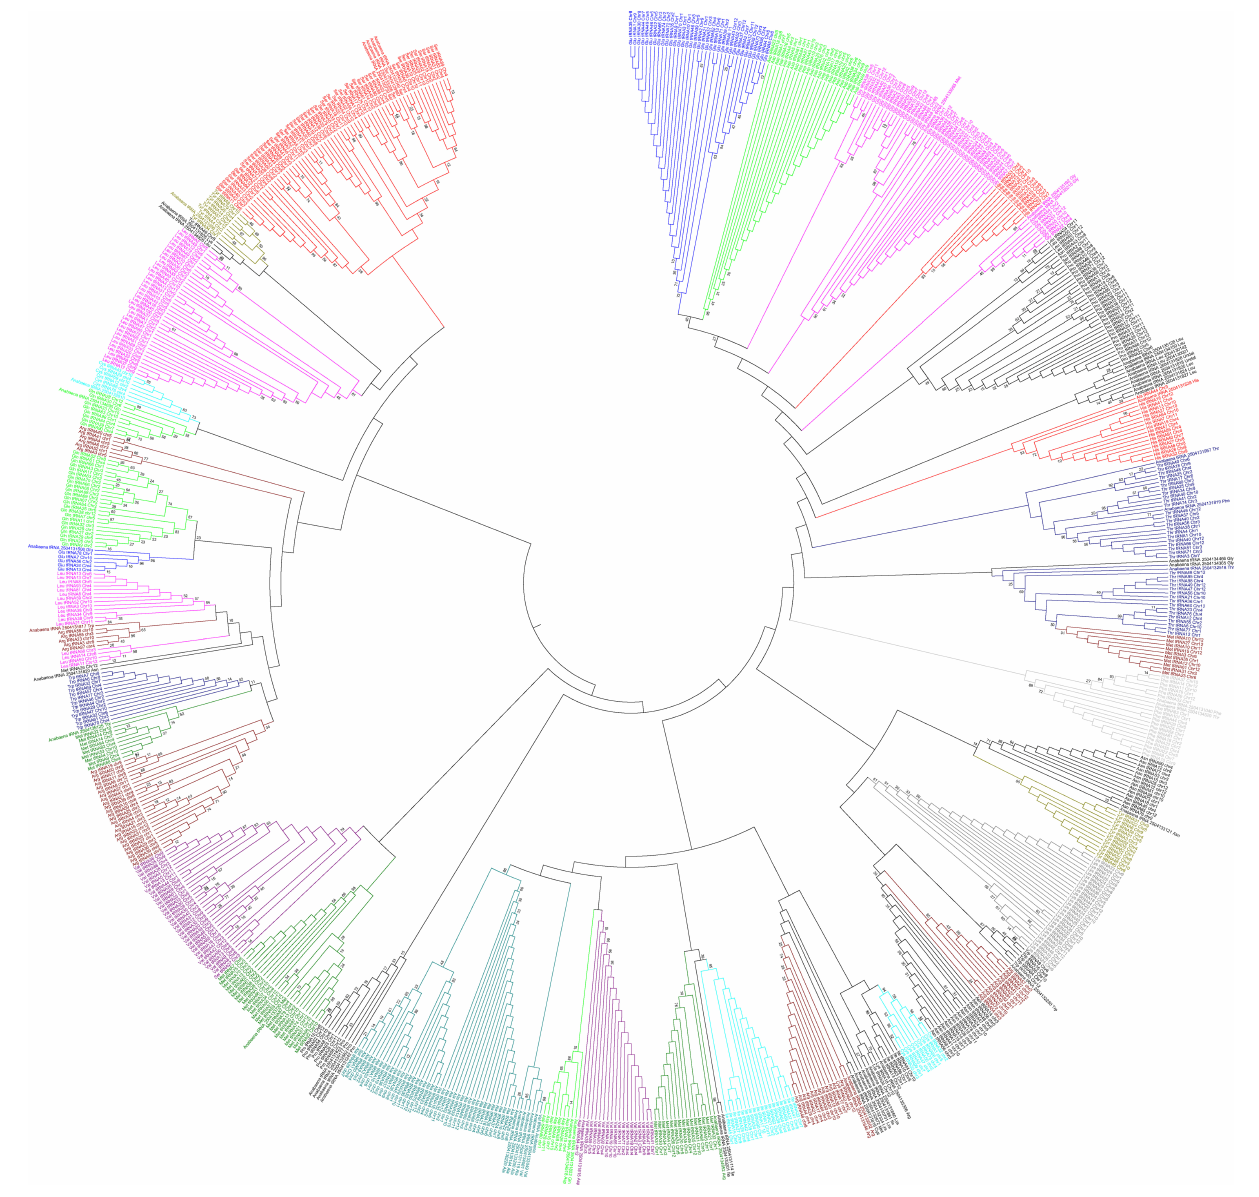
FIGURE 6 | Phylogenetic tree of O. sativa tRNAs was constructed using the tRNA genes of O. sativa. tRNA of A. cylindrica was used as probable prokaryotic common ancestor. Phylogenetic tree was constructed used using MEGA6 software.